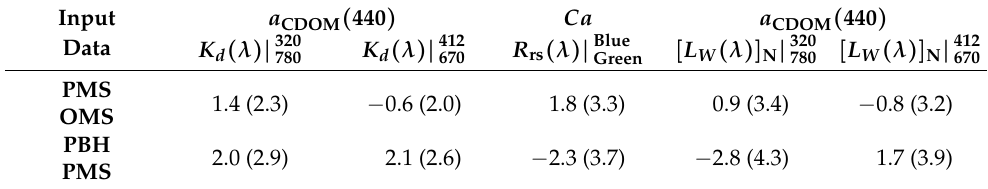
Table 4. The ψ and φ comparison statistics in percent following Table 1 for determining the algorithm output variables when input variables are from two data sources (Tables 2 and 3). Data sources are either same sensor technology in two different instrument systems (PMS and OMS) making contemporaneous observations or two different sensor technologies in the same C-PHIRE instrument (PBH and PMS) making simultaneous observations. Wavebands involved are indicated to right in column headers as individual wavelengths or spectral